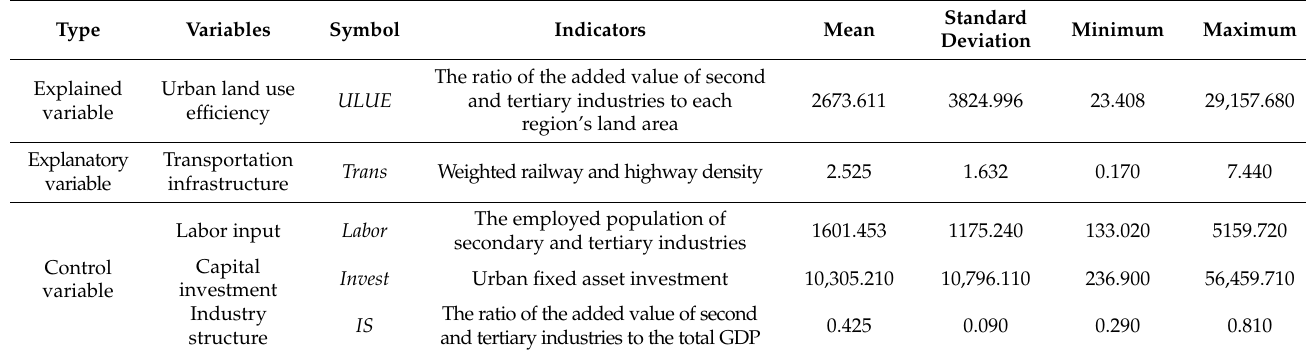
Table 1. Descriptive statistical results of the